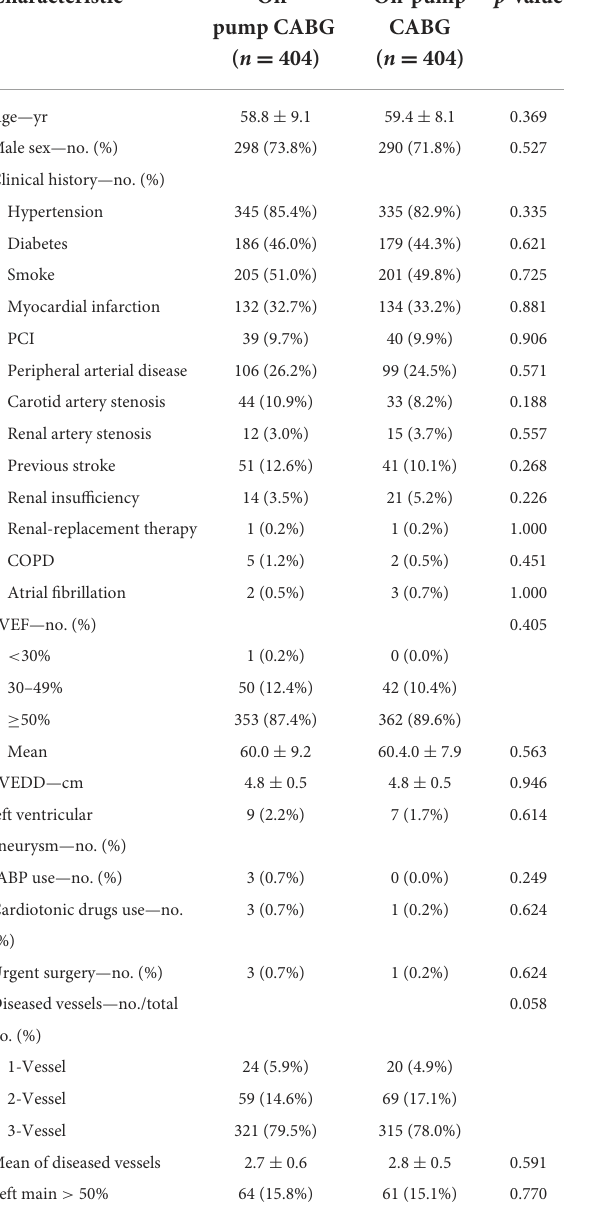
no significant difference in rate of IABP use ( P = 0.803) and low cardiac output syndrome ( P = 0.562) between two groups (Table 3). After propensity matching, OPCAB had lower incidence of new renal insufficiency ( P < 0.01), respiratory failure ( P = 0.001) and reoperation for bleeding ( P = 0.012).